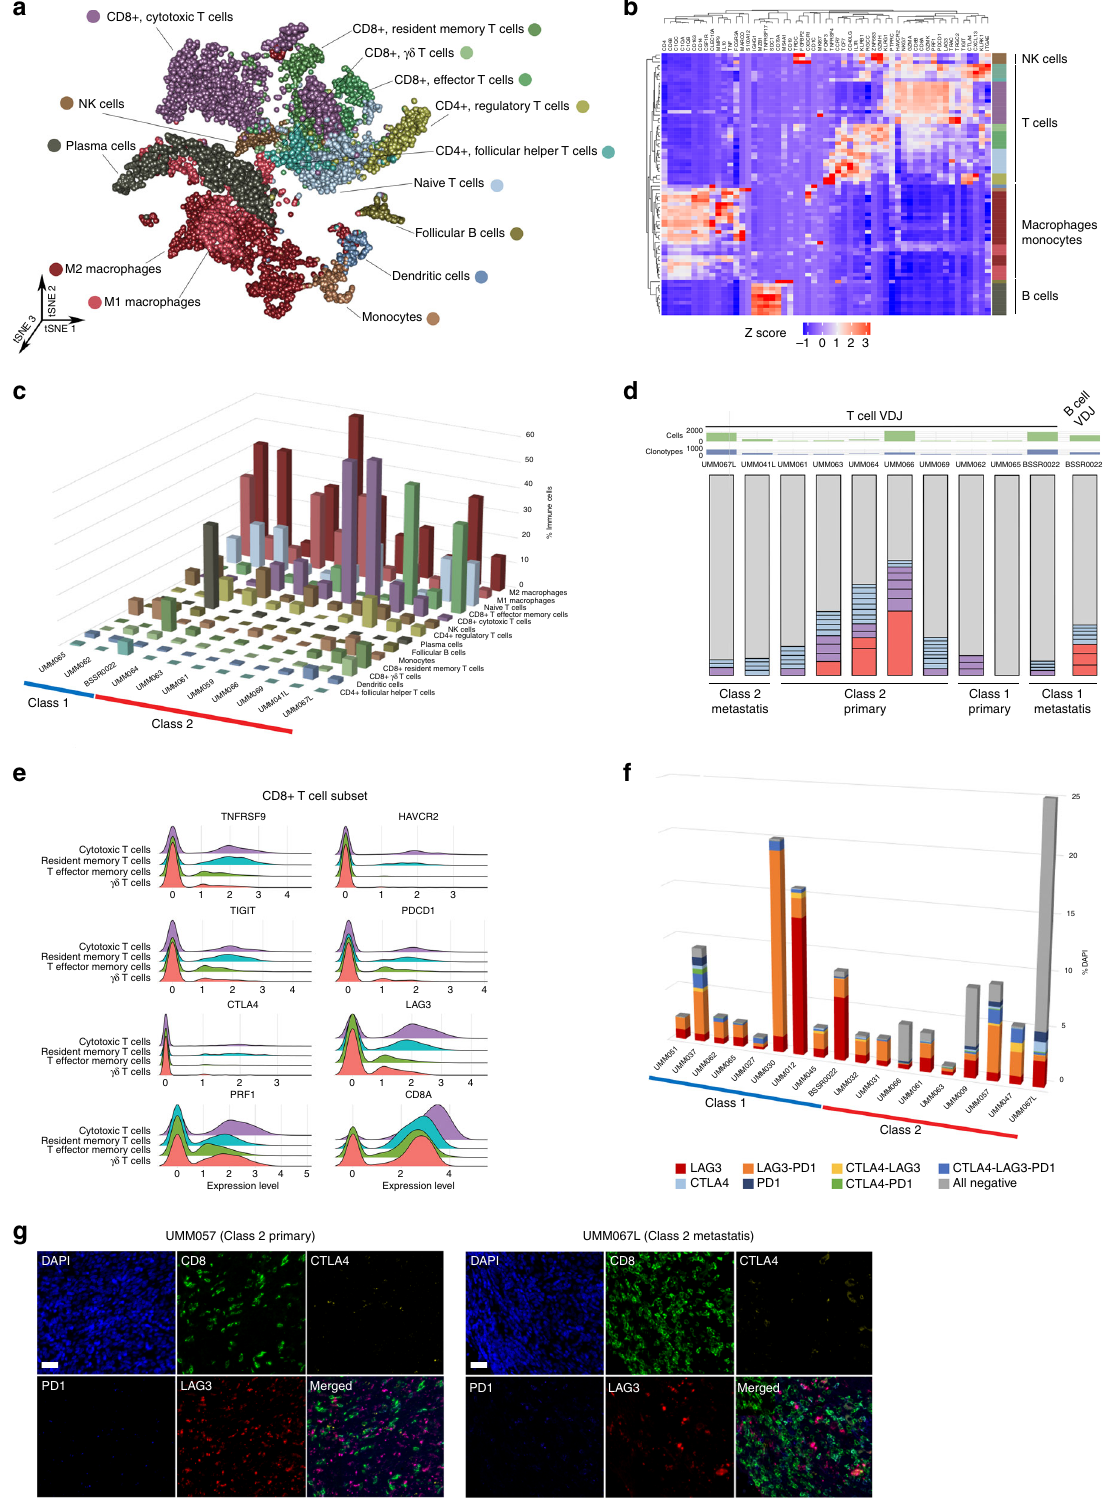
T cells. CD8 + T cell expression of exhaustion-associated immune checkpoint molecules is strongest for LAG3 , variable for TIGIT , and minimal for PDCD1 (PD1 ) , CTLA4 , HAVCR2 (TIM3 ) , and TNFRSF9 (Fig. 4e and Supplementary Fig. 7c, d). Protein expression of LAG3, CTLA4 and PD1 were orthogonally vali- dated using multi-color IHC in 18 samples (Fig. 4f, g and Sup- plementary Fig. 8b). These fi ndings, coupled with the